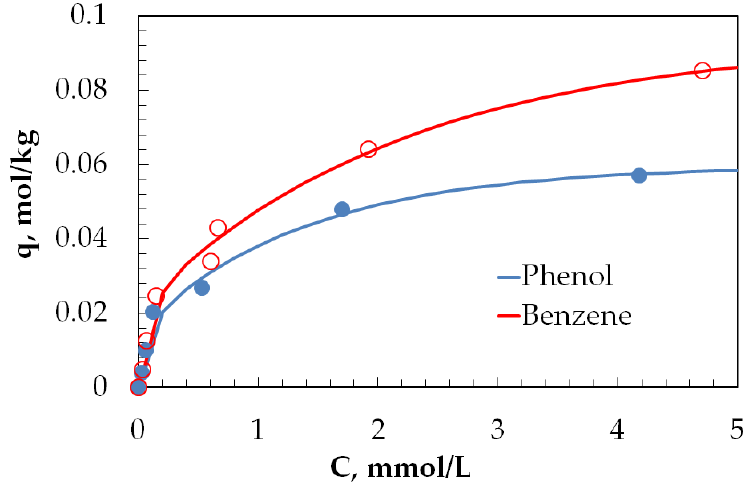
Figure 15. Isotherms of the phenol and benzene sorption on organic material, L/S = 50, 25 C, 60 min.